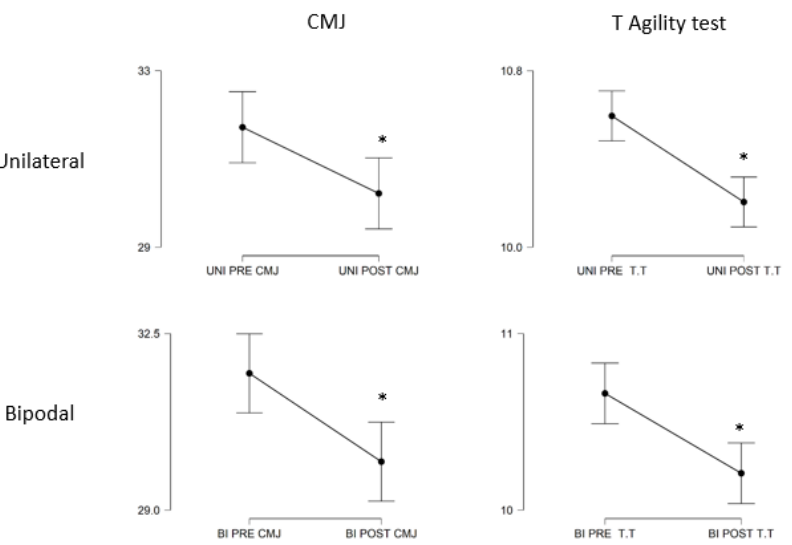
Figure 4. Comparison between the pre-test and the post-test of the PAPE groups in the counter- movement jump (CMJ) and in the T-agility test. * p < 0.05. movement jump (CMJ) and in the T-agility test. * p <